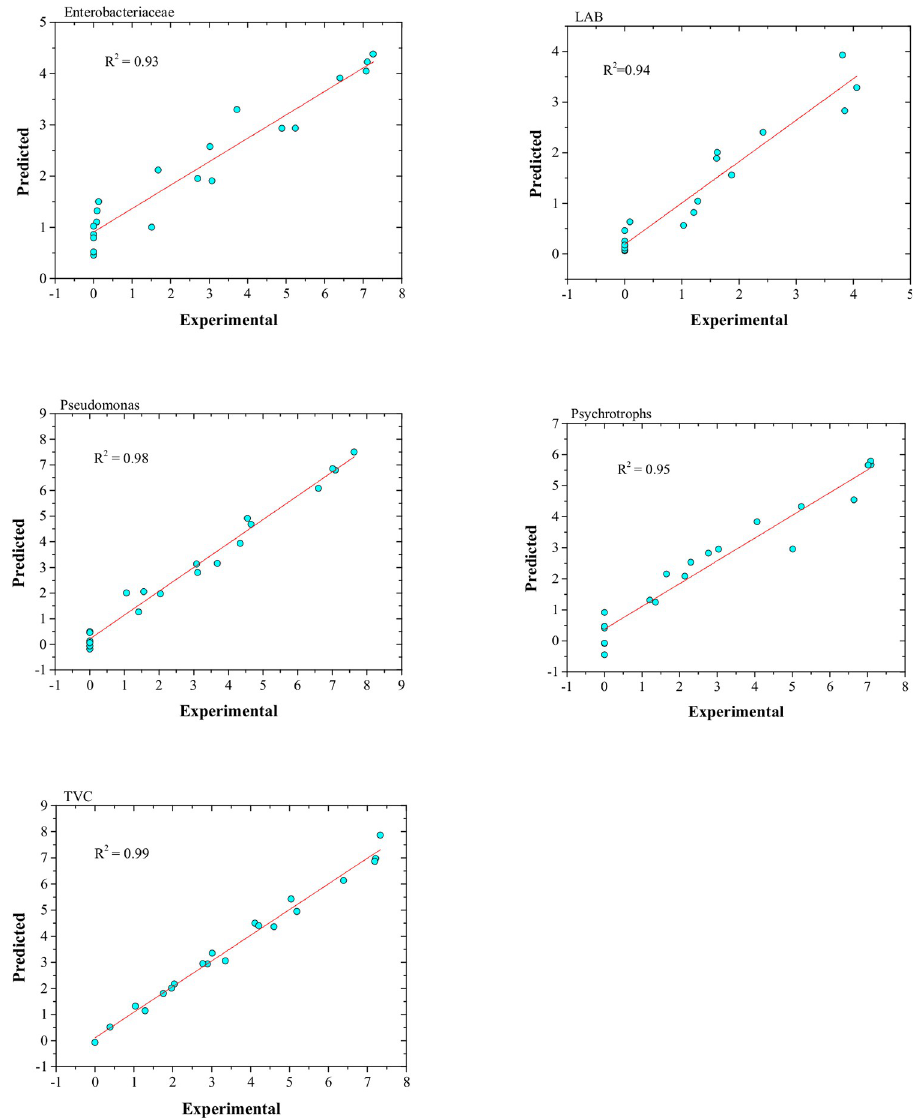
Fig 5. Comparison between predicted and experimental microbial count (Enterobacteriaceae, Lactic Acid bacteria (LAB), Pseudomonas, Psychrotrophs, and total viable count (TVC)). Predicted microbial counts were obtained by the best ANN